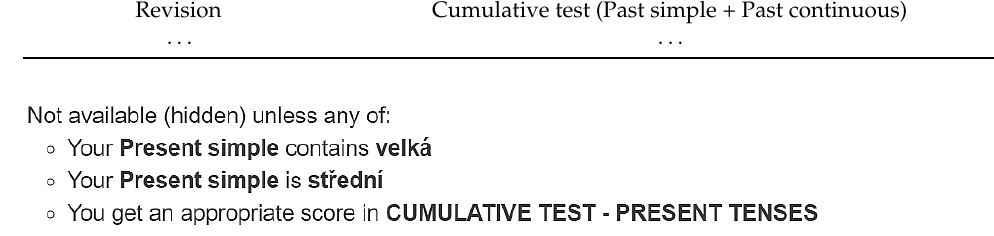
Figure 9. Access restrictions as students see them.